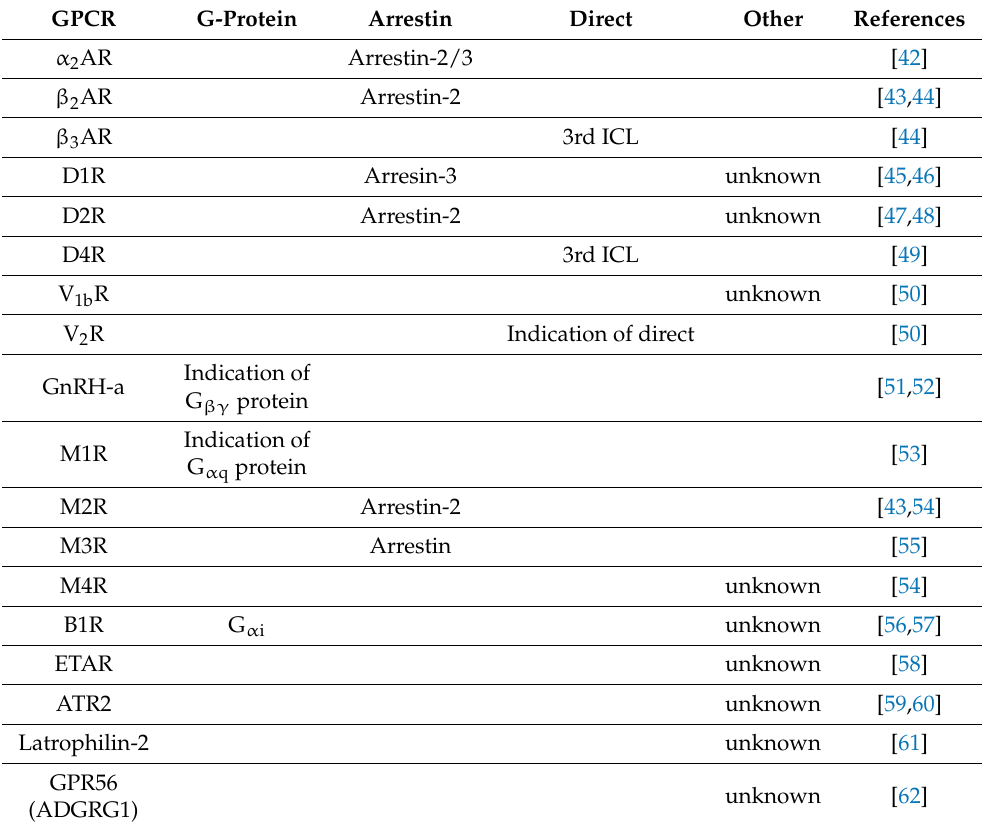
Table 1. Overview of GPCRs that regulate or bind SFKs. Summarized are most of the GPCRs known to activate SFKs in a G protein- or arrestin-dependent manner. Some studies showed a direct interaction between the receptors and the SFKs, while in other studies, activation of the SFK was observed, but a mechanism was not